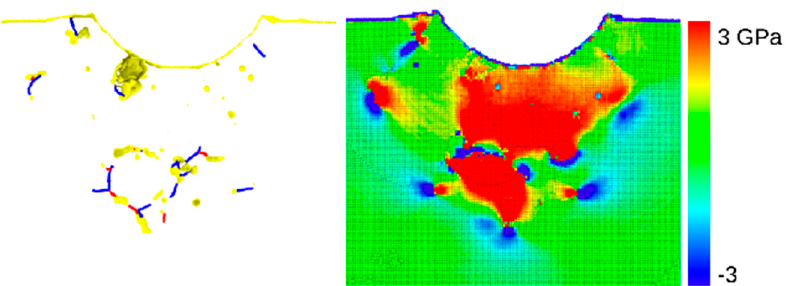
Figure 12. Comparison of the ( right ) hydrostatic pressure and ( left ) dislocation in the specimen at the end of the 10th cycle. Positive pressures are compressive, negative pressures are tensile. Dislocations are colored as in Figure 7. The figure shows a cross-sectional view on the indented specimen; the thickness of the slab in the left-hand image is 2 nm.